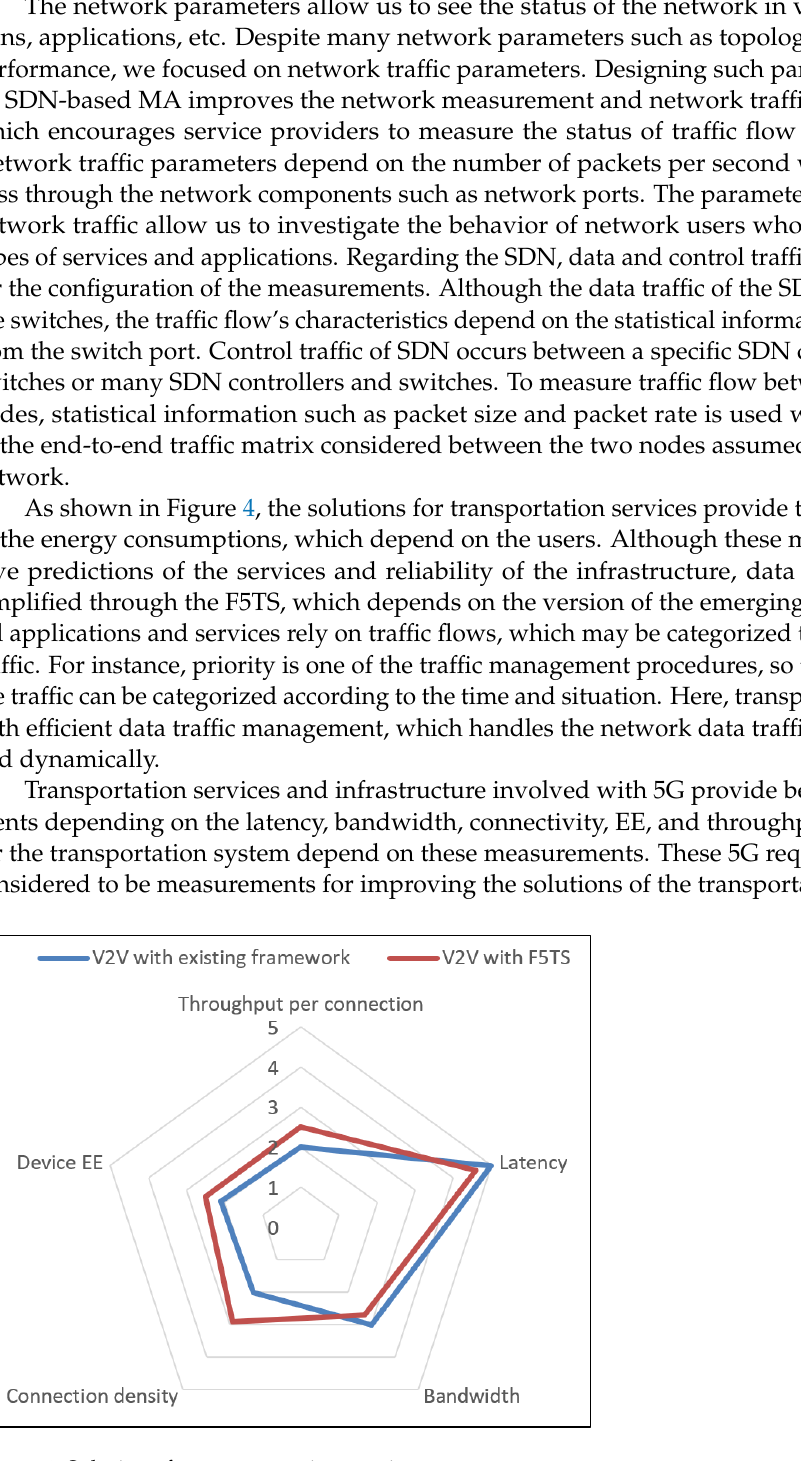
Figure 4. Solutions for transportation services.